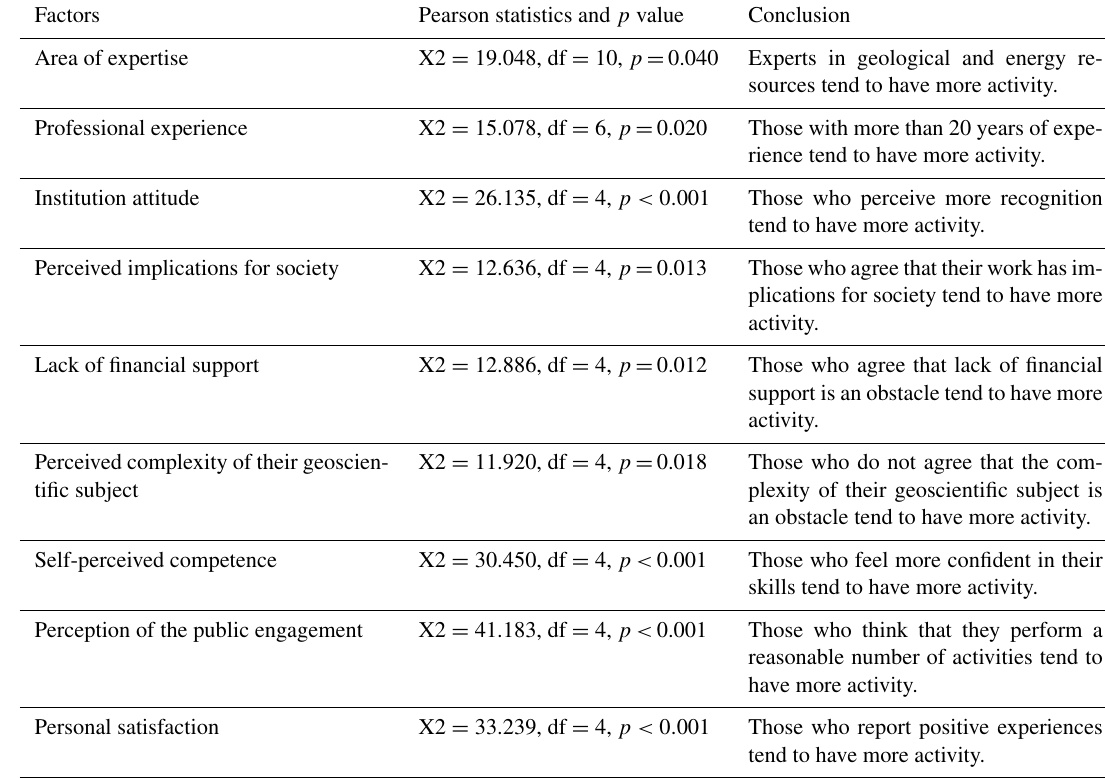
Table 1. Results from chi-square tests